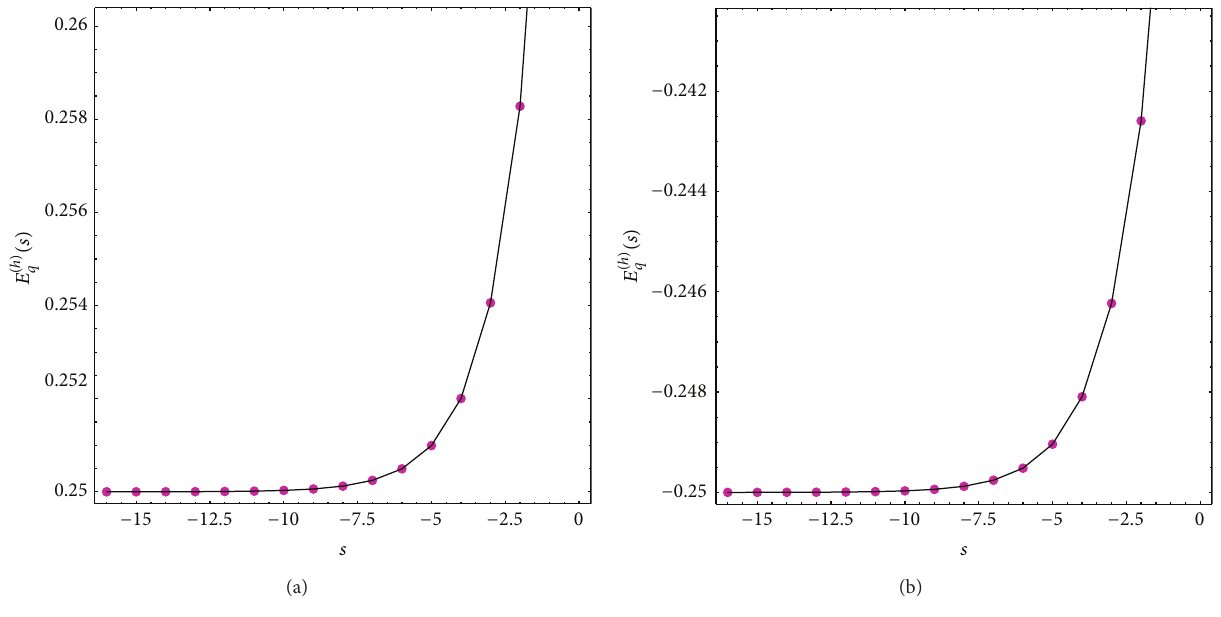
Figure 2: The curve 𝐸 (ℎ) 𝑞 (𝑠) runs through the points 𝐸 (ℎ) −𝑛,𝑞 .